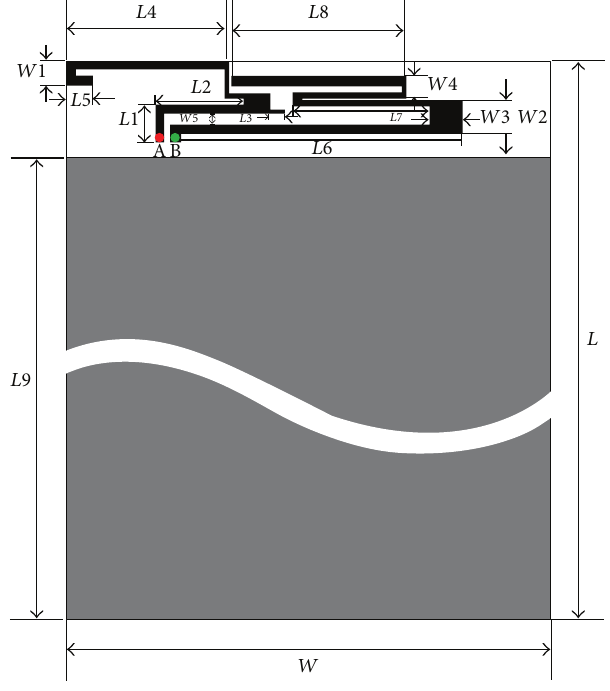
Figure 1: Geometries of the proposed antenna.